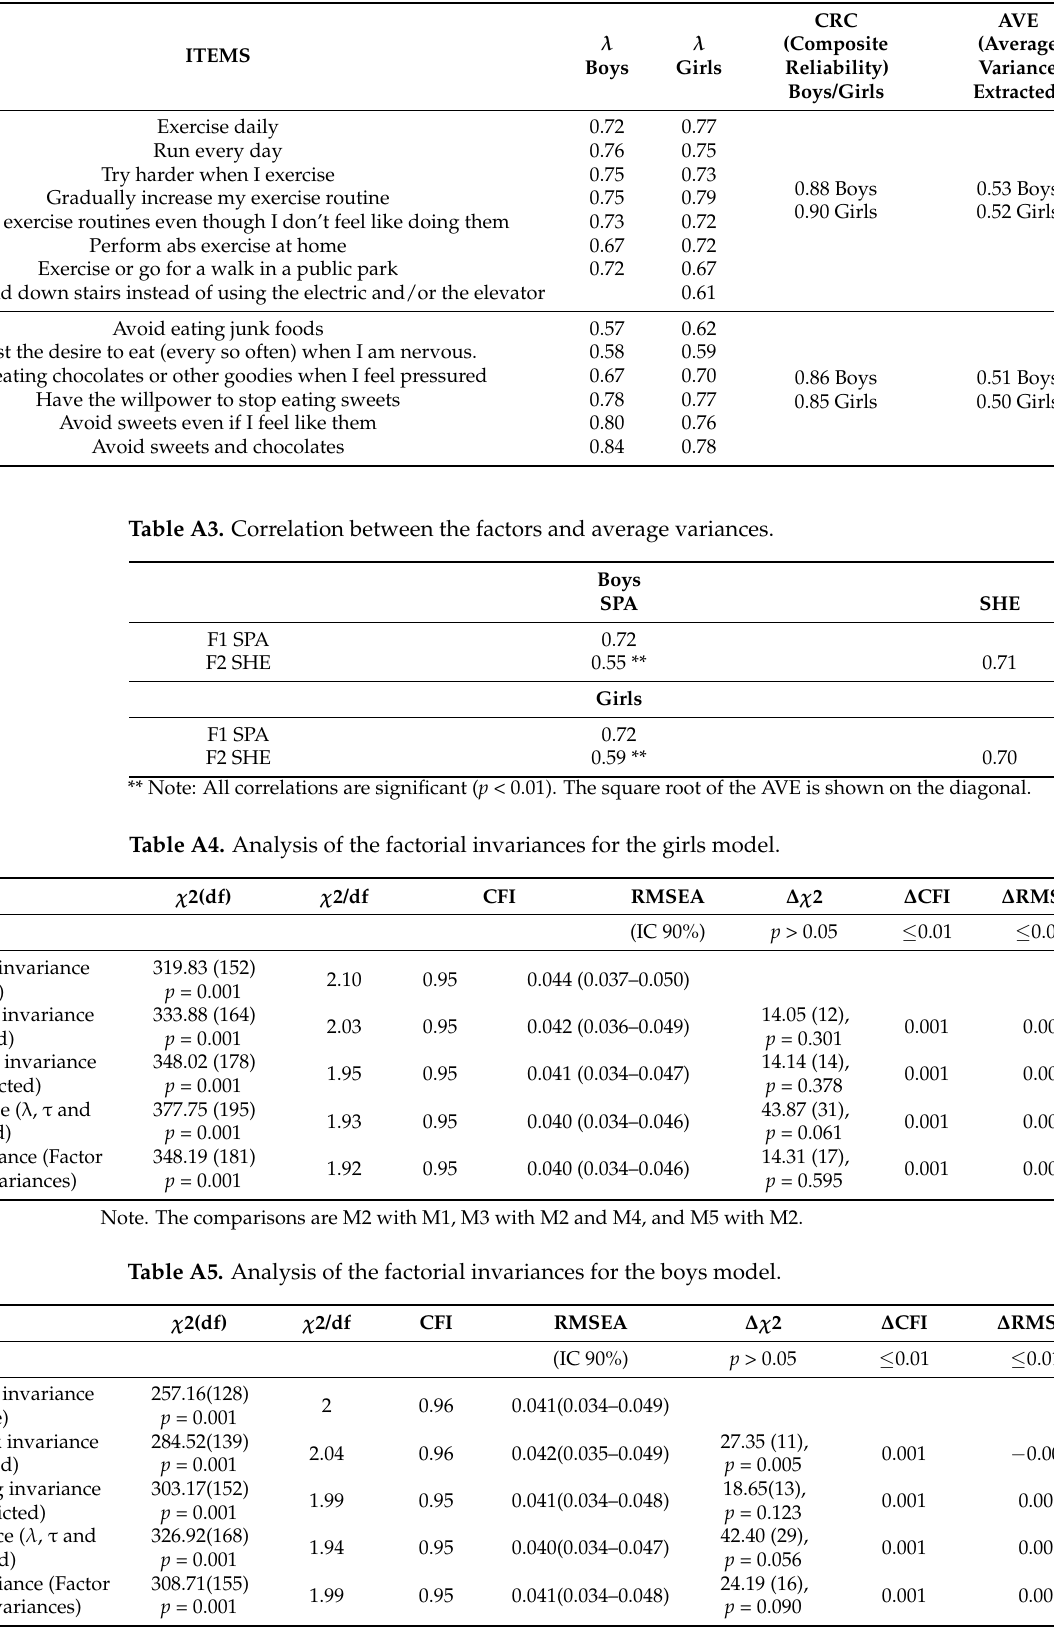
Table A2. Factorial loads ( λ ), composite reliability coefficients (CRC), and average variances extracted (AVE). Boy and girl models.